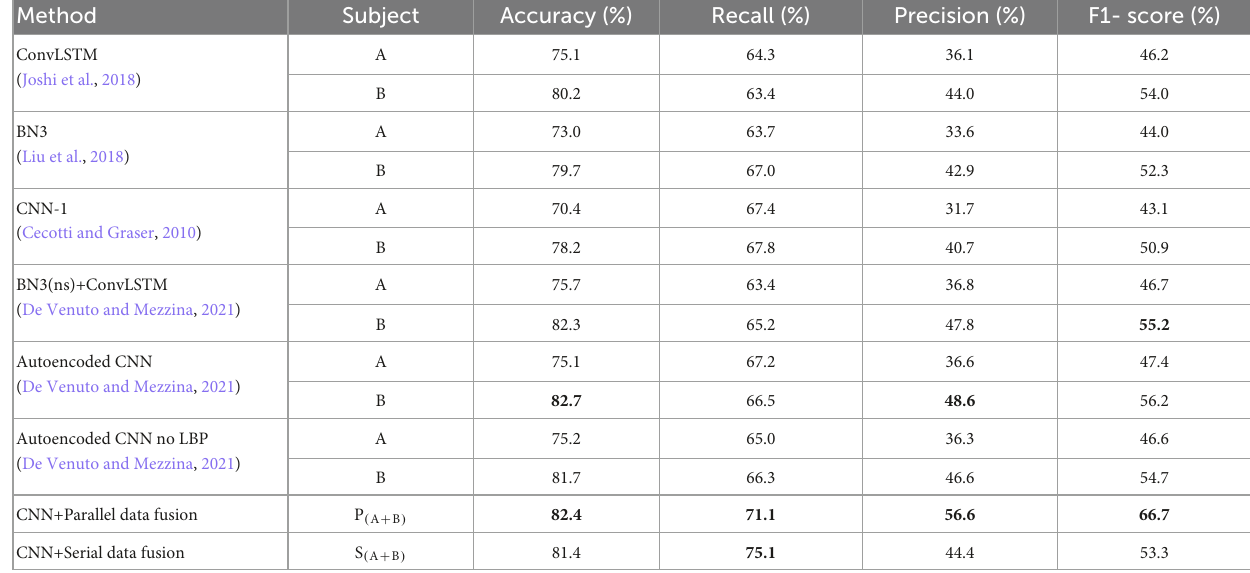
TABLE 5 Results of centralized multi-person electroencephalography (EEG) data fusion convolutional neural network (CNN) and other classification